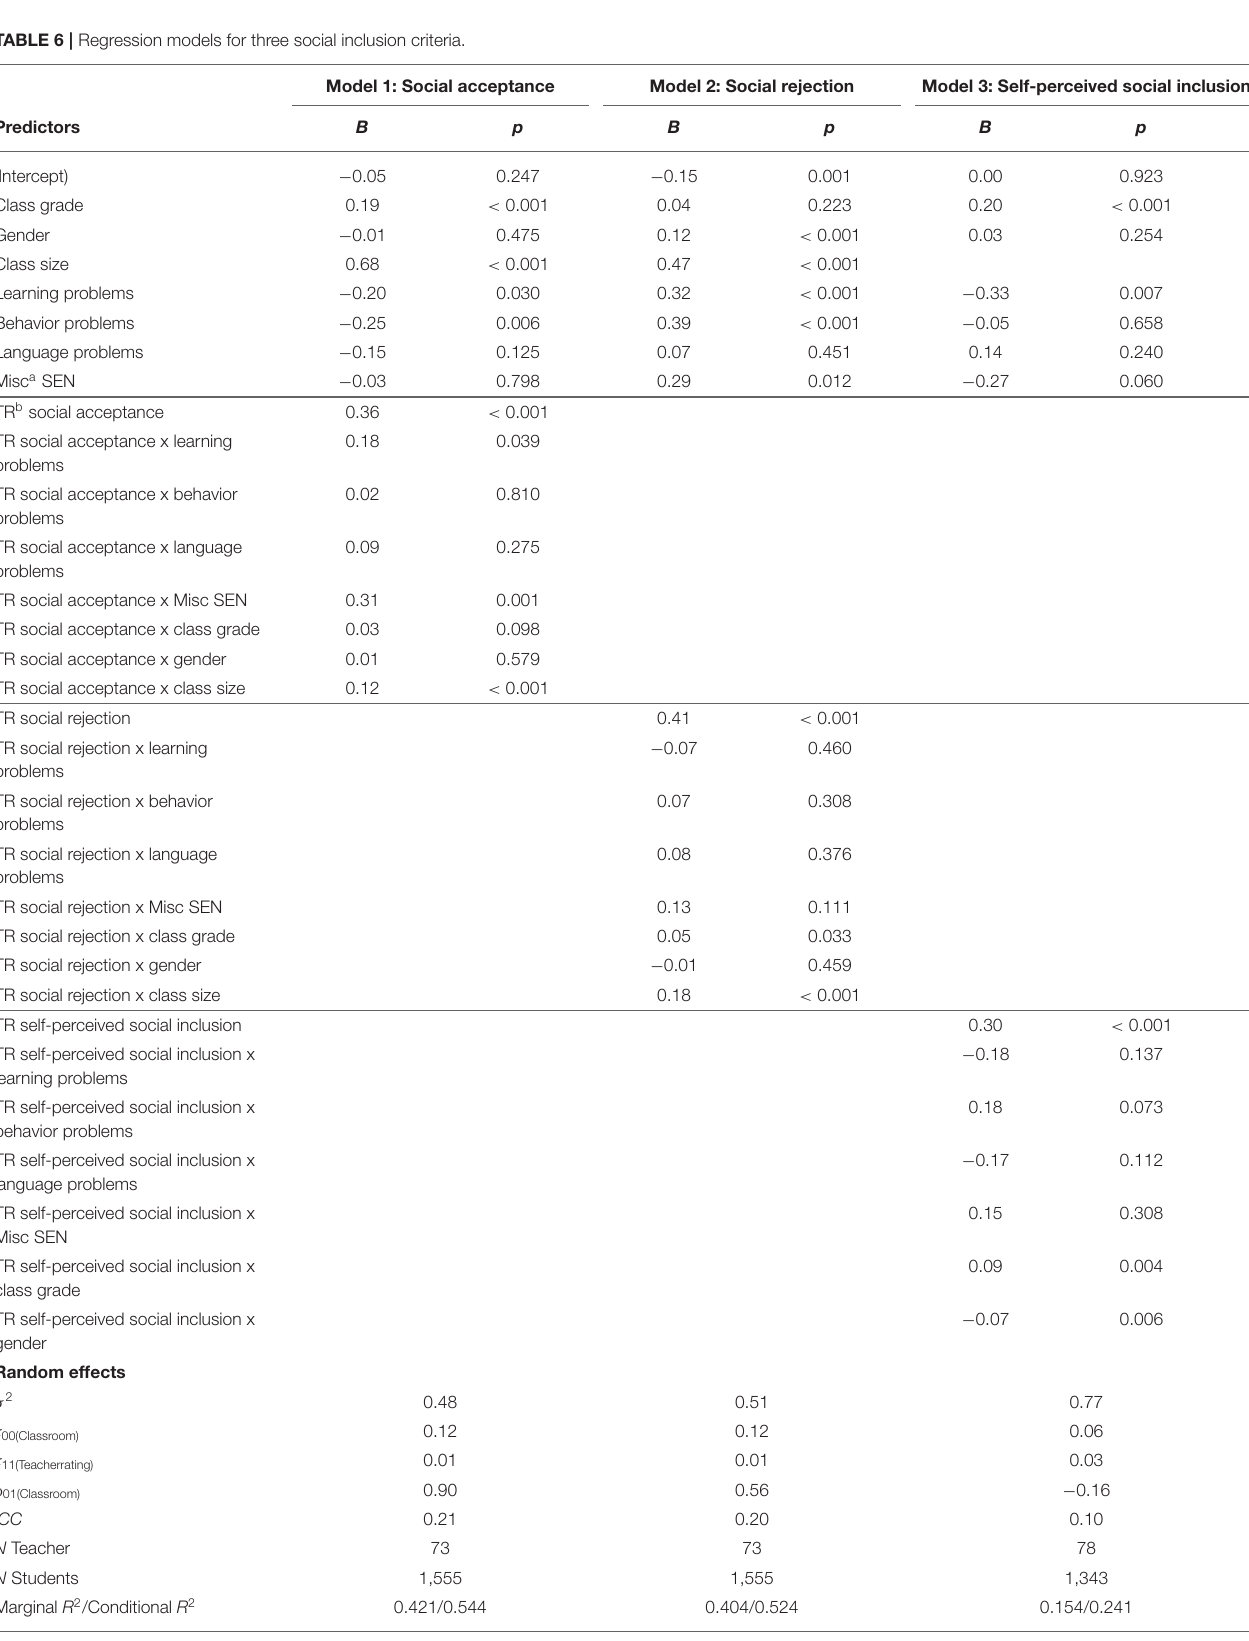
TABLE 6 | Regression models for three social inclusion criteria. Model 1: Social acceptance Model 2: Social rejection Model 3: Self-perceived social